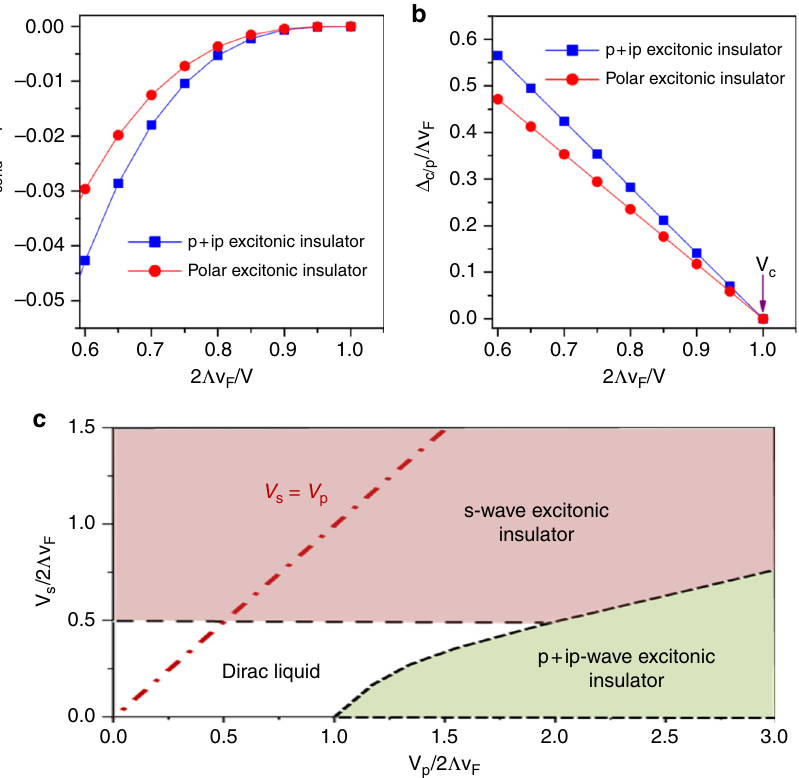
(cid:4) (cid:4) (cid:4) (cid:4) Λ 2 (cid:7) 1 (cid:4) (cid:4) 2 = v 2 c = p F